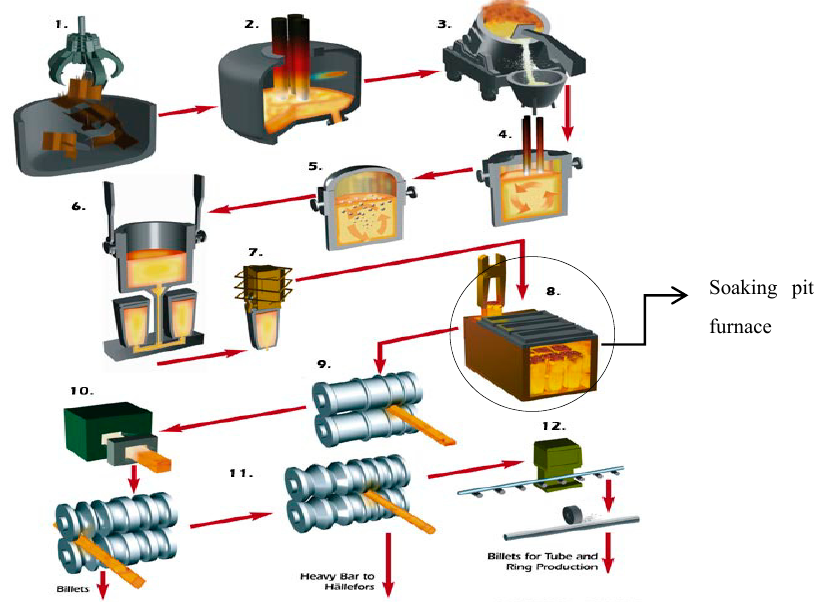
Figure 1. The production route of bars at Ovako Sweden AB, Hofors, Sweden [26].